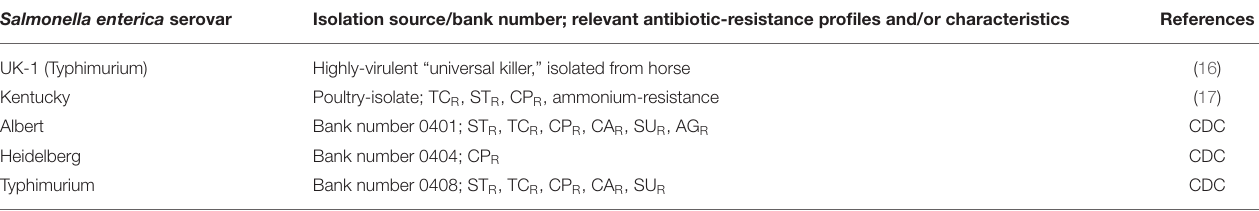
TABLE 1 | Summary of Salmonella isolates tested for in vitro resistance assays. Salmonella enterica